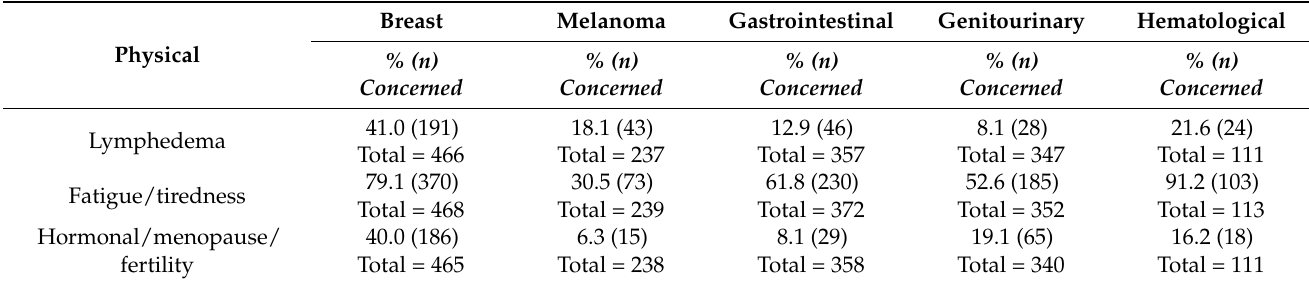
Table 3. Respondents’ concerns in the physical domain (by tumour